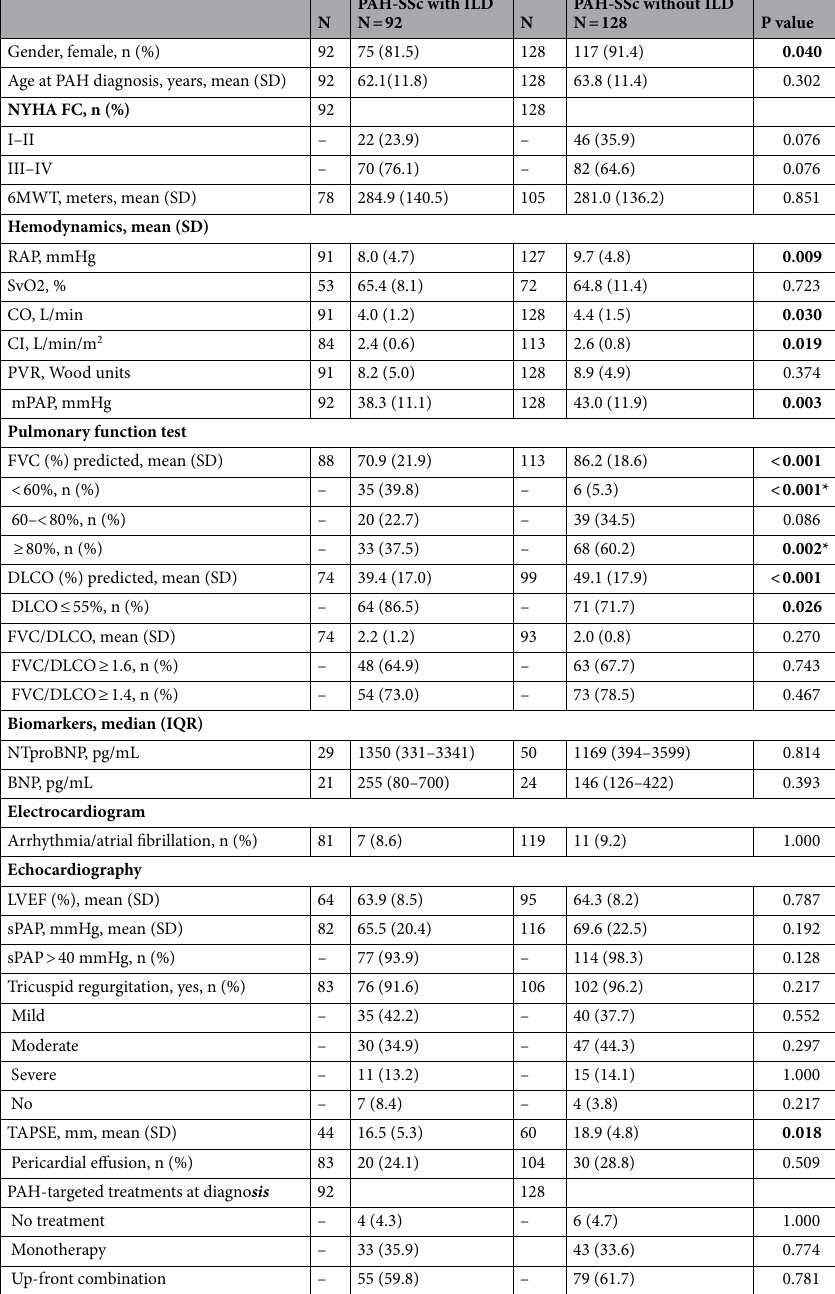
Table 2. Demographic, clinical, and hemodynamic data of patients with PAH-SSc according to the presence of ILD. Significant values are in bold. BNP B-type natriuretic peptide, CI cardiac index, CO Cardiac